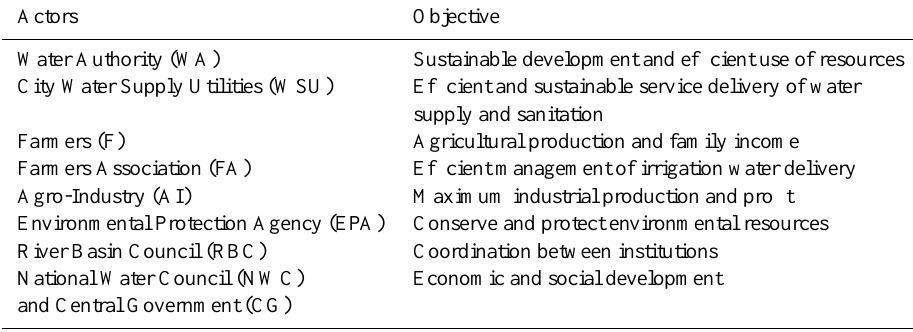
Table 2. Actors and their objectives in the Ravilla simulation